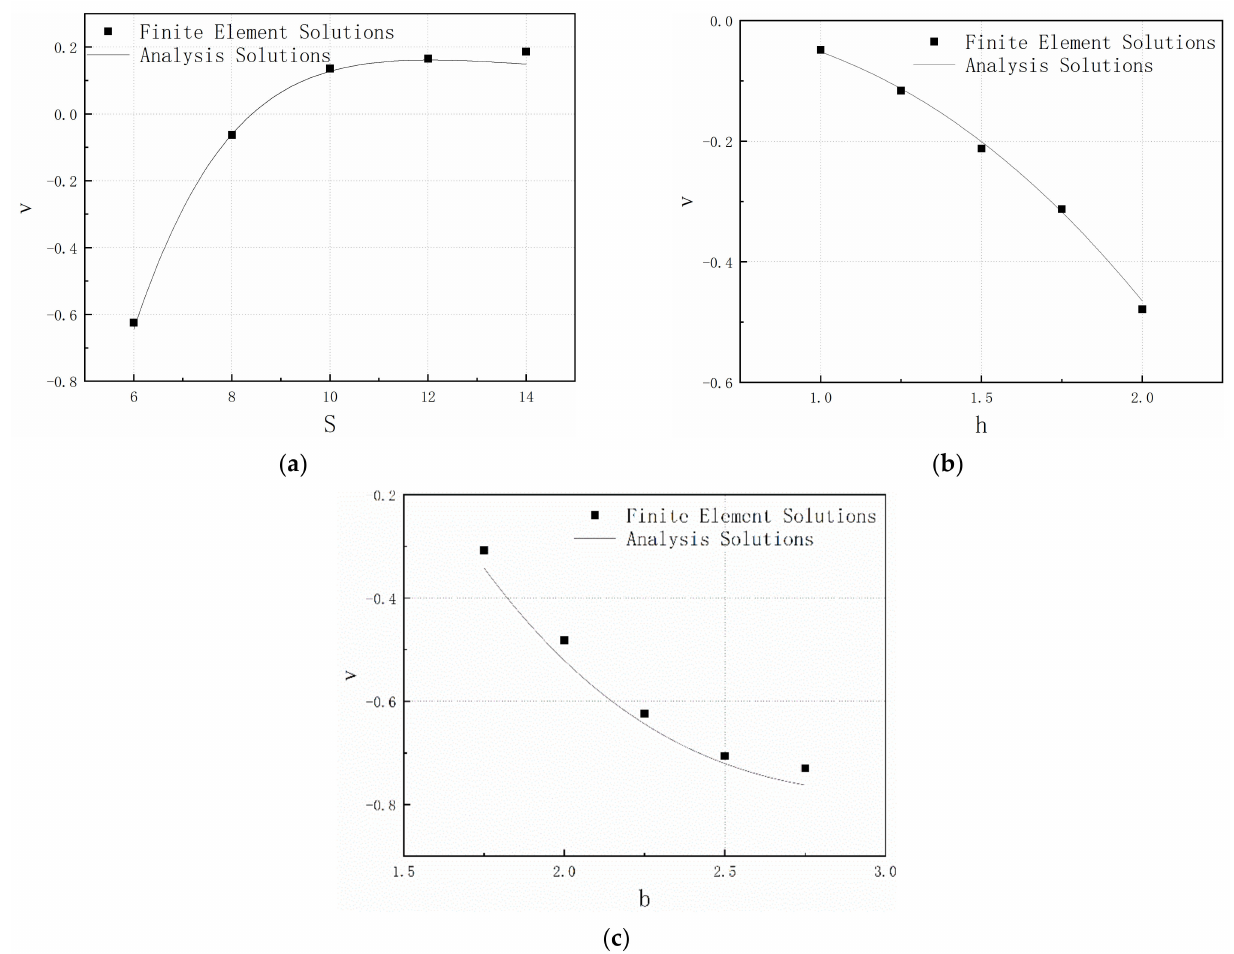
Figure 7. Comparison of simulated and analytical solutions when loaded in the y-direction: ( a ) effect of cellular length S on Poisson’s ratio; ( b ) effect of vertical short cellular height h on Poisson’s ratio; ( c ) effect of horizontal short cellular length b on Poisson’s